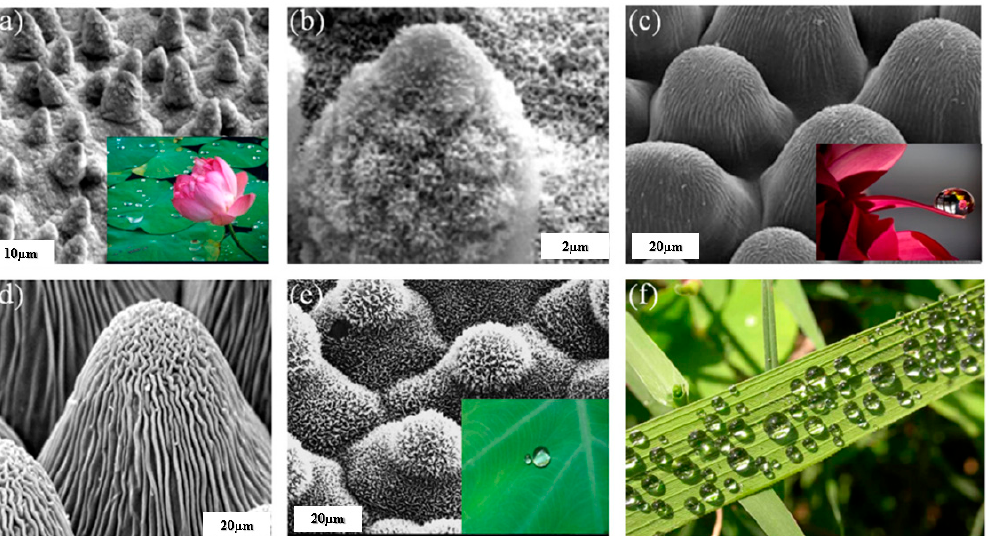
Figure 1. ( a ) SEM image of a lotus leaf with inset entailing the water droplet on the lotus leaf, ( b ) High magnification image of lotus leaf depicting the hierarchical structures, ( c ) SEM image of cuticles on the papillae of a dahlia with inset depicting the droplet on dahlia petal, ( d ) SEM image of cuticles on papillae of rose petal, ( e ) Epicuticular wax platelets over the taro leaf with inset depicting the droplet over the leaf, ( f ) Water droplets over the rice leaf entailing the super-hydrophobicity [1]. Copyright permission from IOP, 2015.